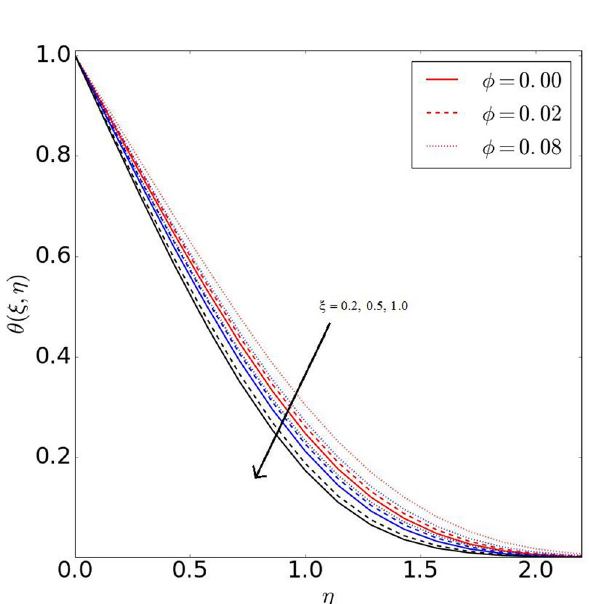
Fig. 12 Velocity profile with different 𝜙 and 𝜉 = 0.2, 0.5, 1 for Al 2 O 3 -water nanofluid